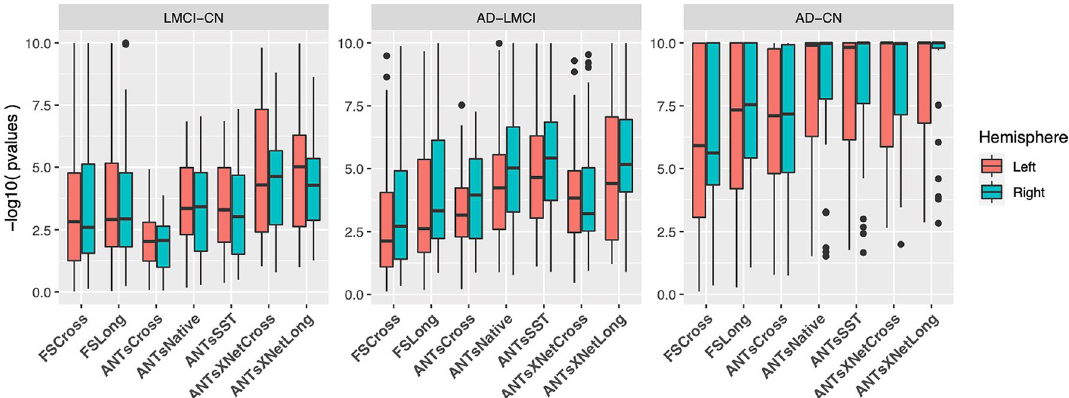
Figure 6. Measures for the supervised evaluation strategy where log p-values for diagnostic differentiation of LMCI-CN, AD-LMCI, and AD-CN subjects are plotted for all pipelines over all DKT